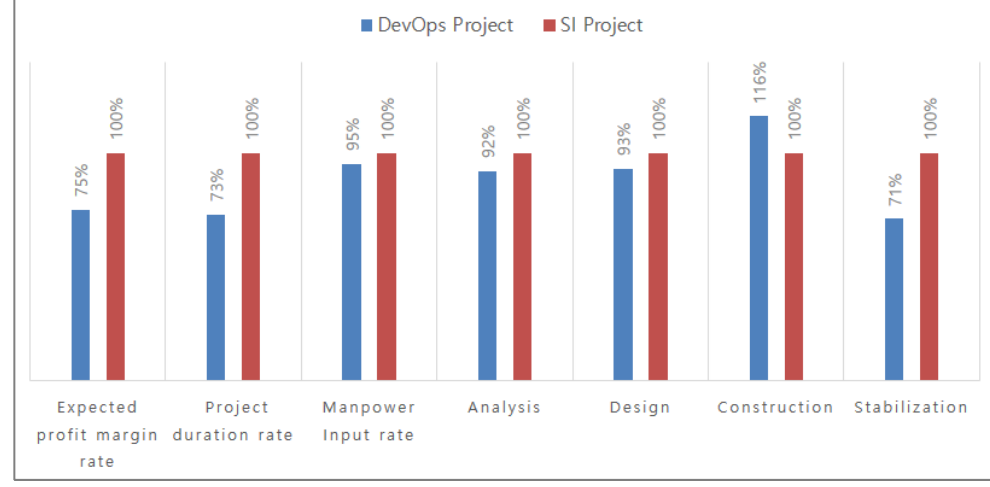
Figure 16. Comparison of Verification Items by Project.